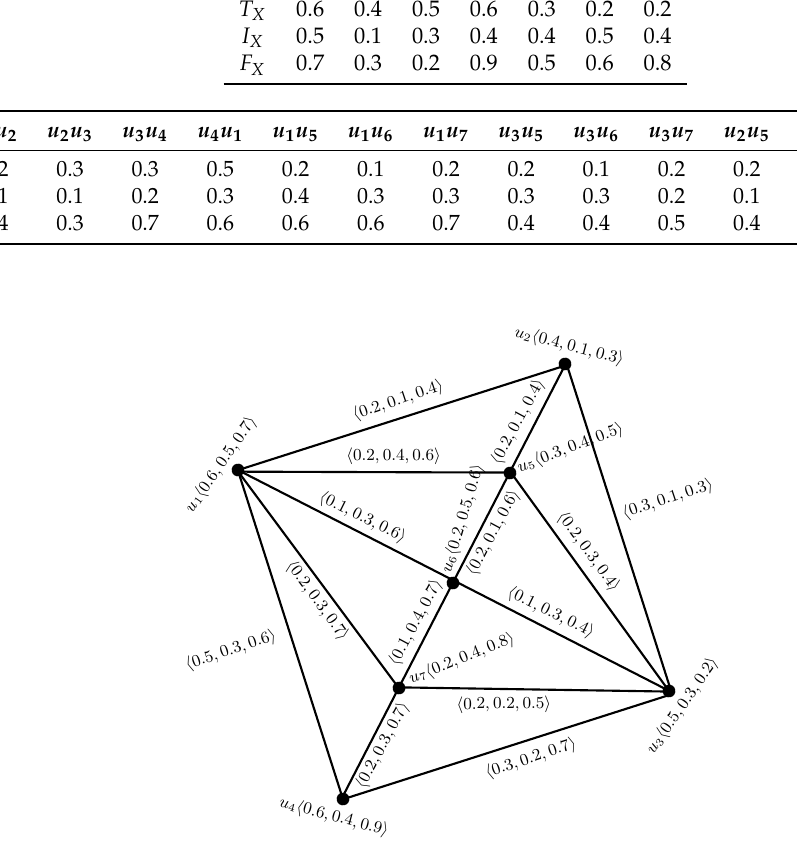
Figure 1. Single-valued neutrosophic Figure 1: Single-valued neutrosophic graph.